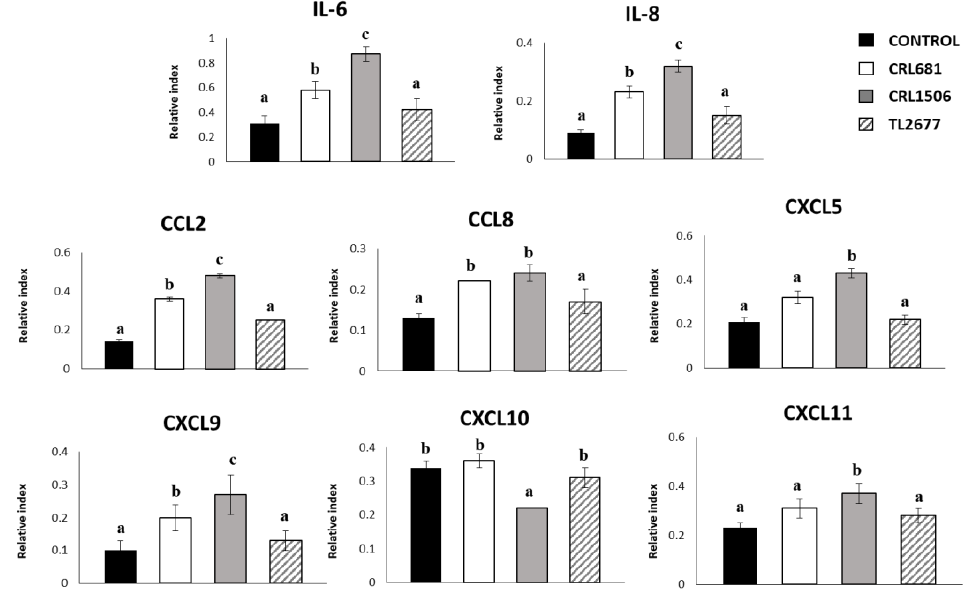
Figure 1. Effect of Lactiplantibacillus plantarum CRL681, CRL1506 or TL2677 on the expression of cytokines and chemokines in porcine intestinal epithelial (PIE) cells. PIE cells were stimulated with CRL681, CRL1506 or TL2677 strains for 48 h. Untreated cells were used as controls. The expression of cytokines (IL-6) and chemokines (CCL2, CXCL5, CXCL8, CXCL9, CXCL10, CXCL11, and CCL8) were studied at 48 h after lactobacilli stimulation (basal). The results represent three independent experiments. Results are expressed as mean ± SD. Bold letters indicate significant differences when compared to the control group ( p < 0.05).